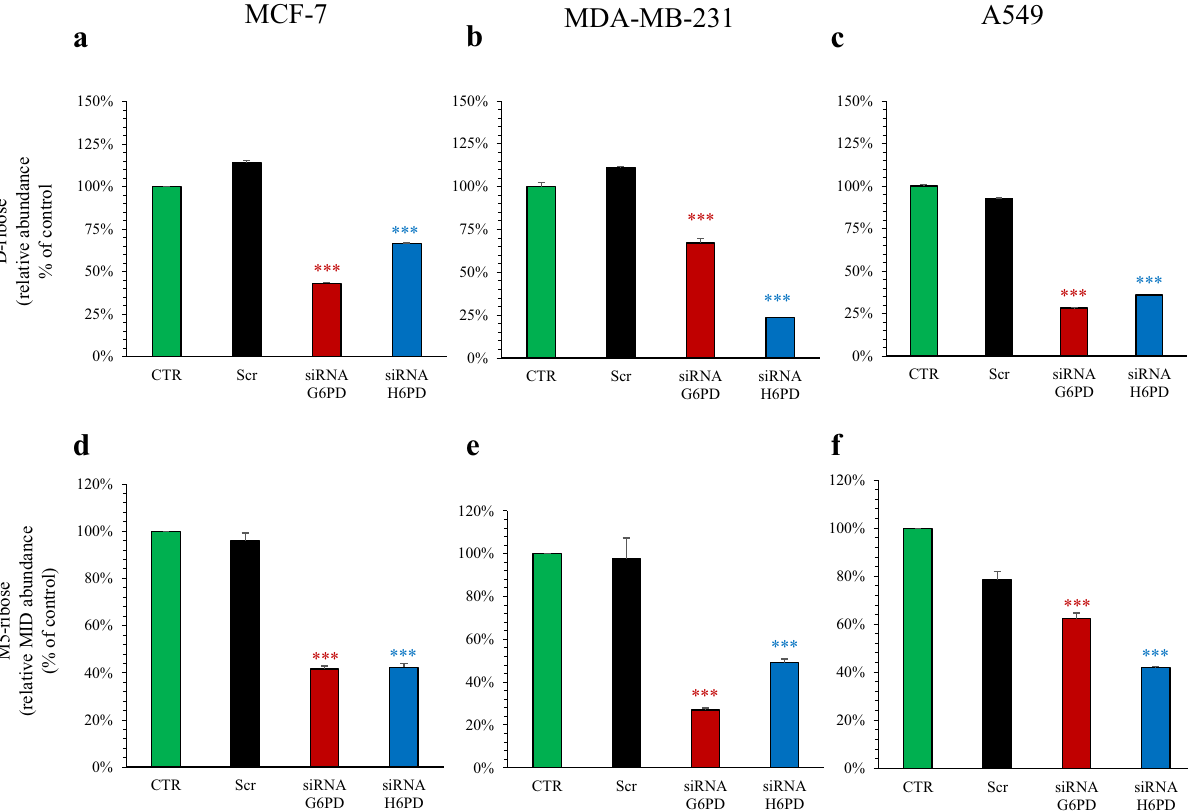
Figure 4. Effect of G6PD and H6PD silencing on cell content of d-ribose and M5-ribose. Relative metabolite abundance of d-ribose in MCF-7 ( a ), MDA-MB-231 ( b ) and A549 ( c ) under control condition (CTR, green), scramble siRNA (Scr, black), siRNA G6PD (red) and siRNA H6PD (blue). Scramble siRNA-transfected cells did not significantly affect d-ribose level in all cell lines. By contrast, silencing G6PD expression significantly decreased d-ribose level in all cell lines. The same response was obtained after down-regulation of H6PD. Mass isotopomer distribution (MID) of M5-ribose in MCF-7 ( d ), MDA-MB-231 ( e ) and A549 ( f ) under control condition (CTR, green), scramble siRNA (Scr, black), siRNA G6PD (red) and siRNA H6PD (blue). G6PD down-regulation significantly decreased M5-ribose content in all cell lines compared to the respective CTR. Similarly, H6PD silencing significantly reduced M5-ribose in breast cancer lines and lung adenocarcinoma cells. Data are expressed as % of CTR ± SD. ***p < 0.001 vs corresponding